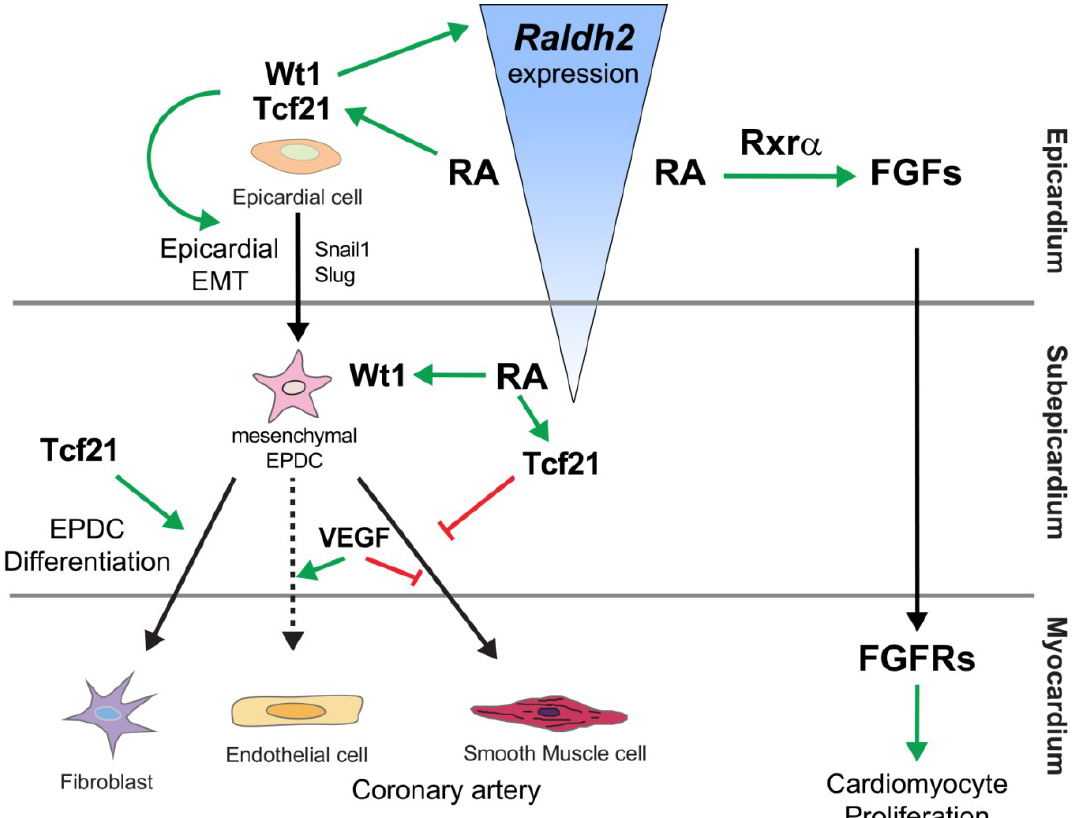
Figure 4. Summary of the role of retinoic acid signaling in the regulation of coronary formation and myocardial growth. Retinoic acid (RA) signaling activates the expression of several Fgfs including Fgf2, Fgf9 and probably Fgf16 and Fgf20. A major role of RA signaling in epicardial cells is to induce the expression of the transcription factors Wt1 and Tcf21 (Pod1) [108]. These transcription factors control epithelial-to-mesenchymal transition (EMT) of epicardial cells through the activation Snail and Slug . Mesenchymal epicardium-derived cells (EPDCs) give rise to interstitial fibroblasts, coronary smooth muscle cells and coronary endothelial cells in the heart. However, different opinions exist on the origin of the coronary endothelial cell from EPDCs since a recent study demonstrated that some murine coronary endothelial cells arise from both the sinus venosus and the endocardium but not from proepicardial cells [100,109,110]. Raldh2 is highly expressed in epicardial cells, and progressively lost in EPDCs when these cells differentiate. Thus, RA signaling, together with VEGF, acts on the differentiation of several EPDC lineages including fibroblasts, coronary endothelial and smooth muscle